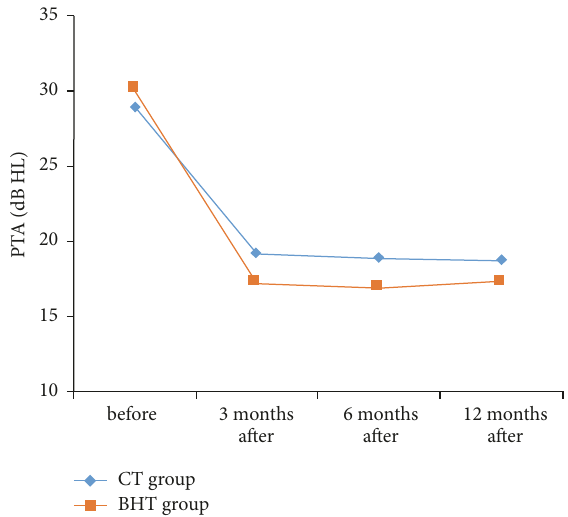
Figure 8: The trend of the change in SDS parameter in two groups.